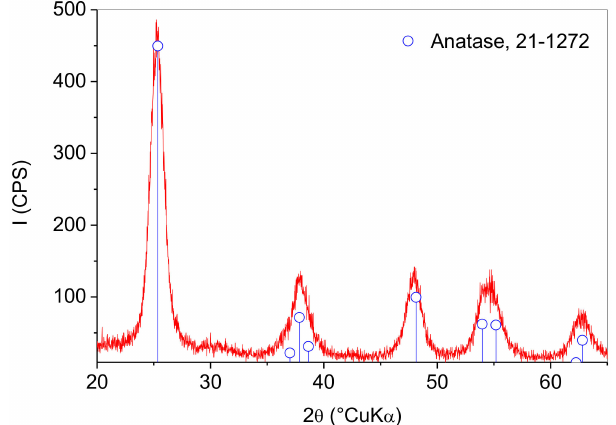
Figure 2. XRD pattern of the prepared photocatalyst.